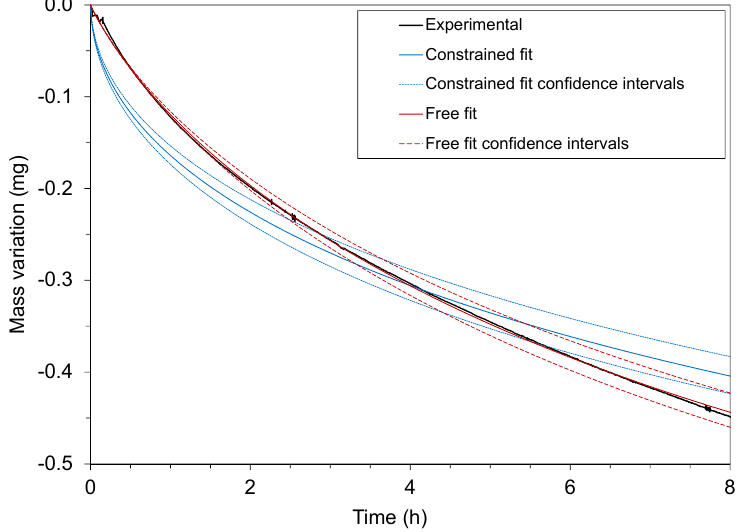
Figure 3. Comparison of the free fit (surface evaporation and domain diffusion compete) and the constrained fit (diffusion-limiting) cases with the experimental desorption data acquired with PE pellets contaminated with biphenyl, at 70 ◦